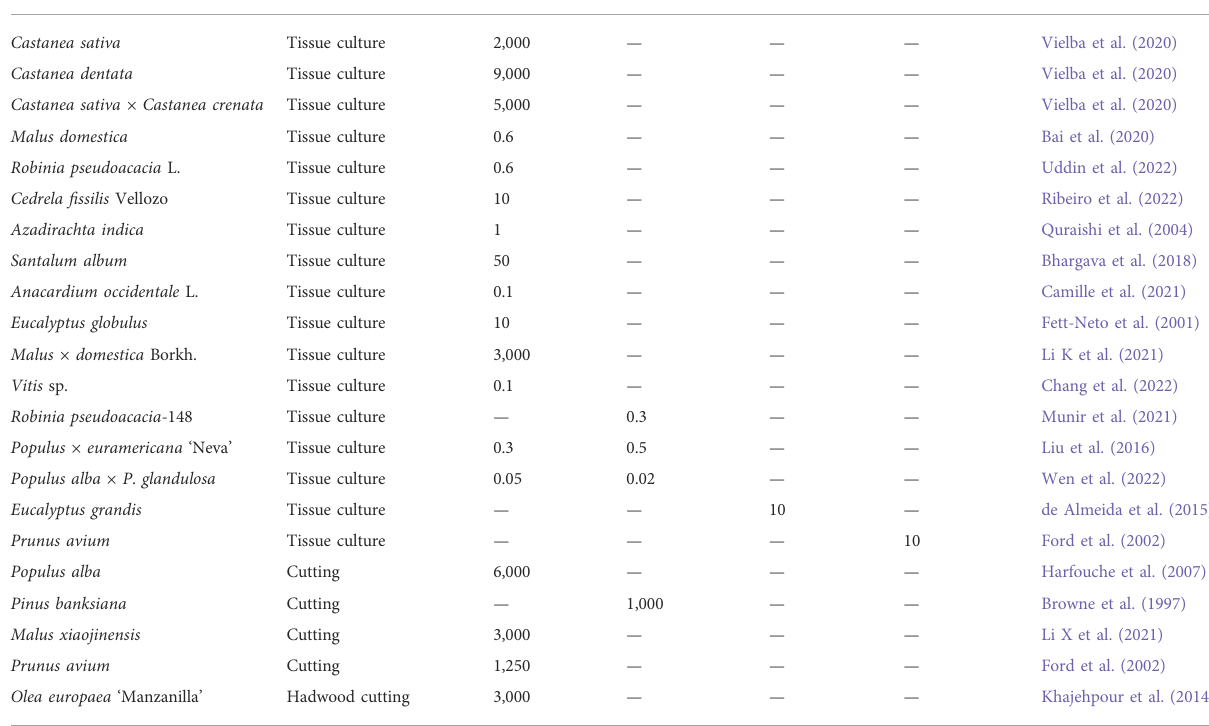
TABLE 1 Exogenous hormone application of different woody species during clonal propagation. Species